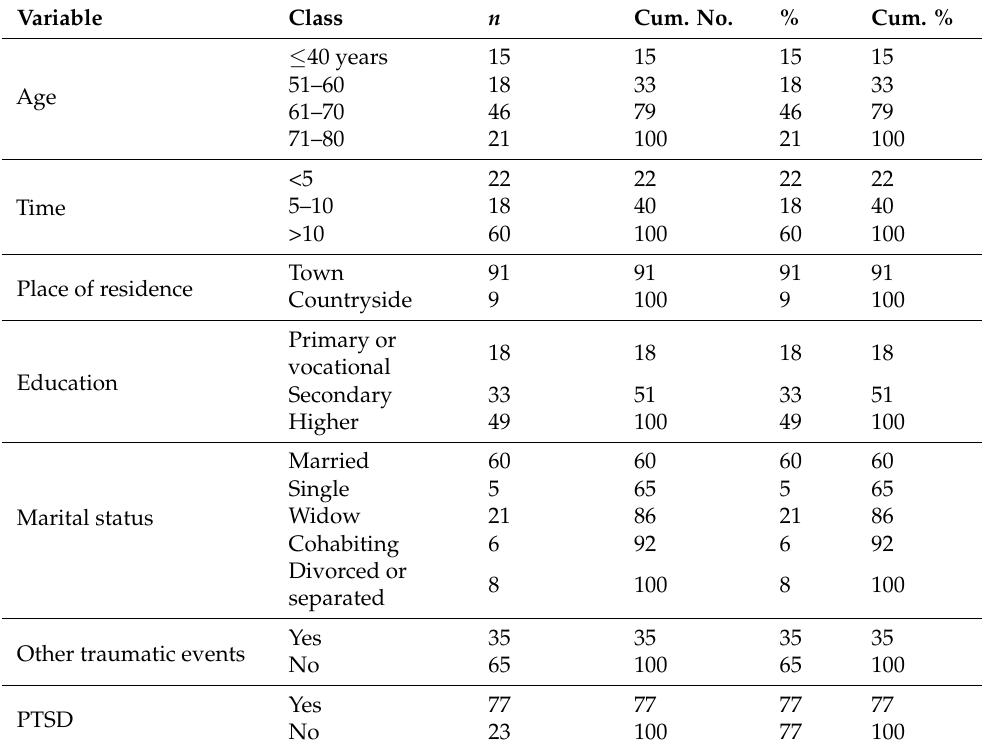
Table 1. Study group description ( n =